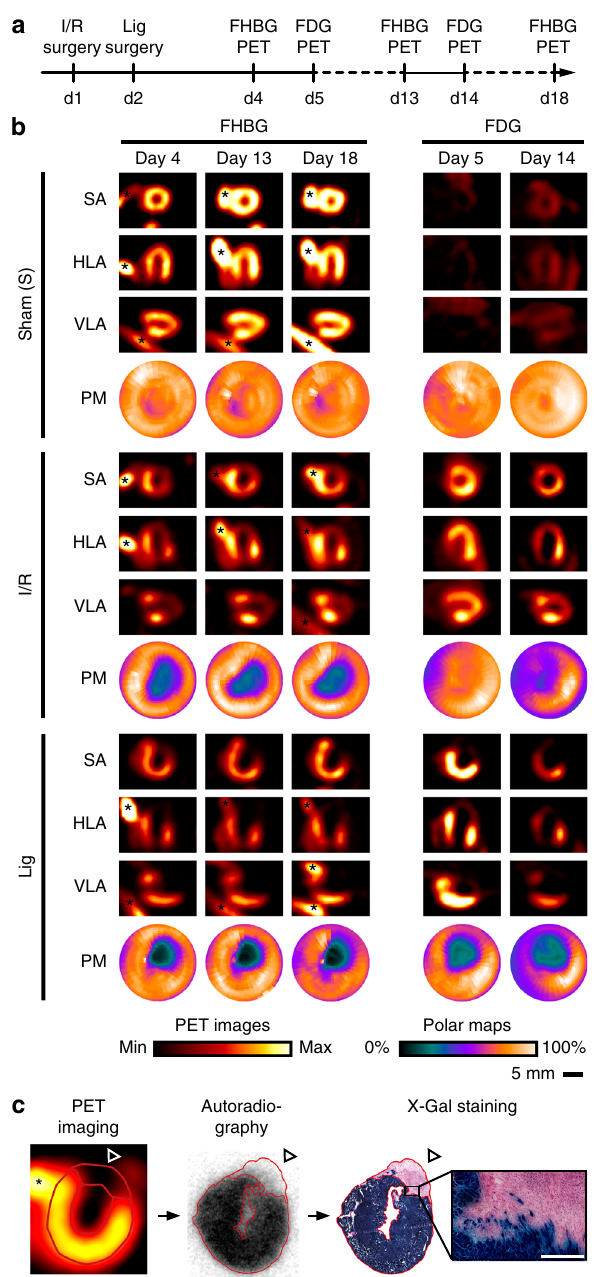
region ( open arrowheads ). High-magni fi cation image shows the border region between healthy and infarcted tissue at single-cell resolution (enlarged from overview picture; scale bar : 250 µ m). See also Supplementary Figs 6 and